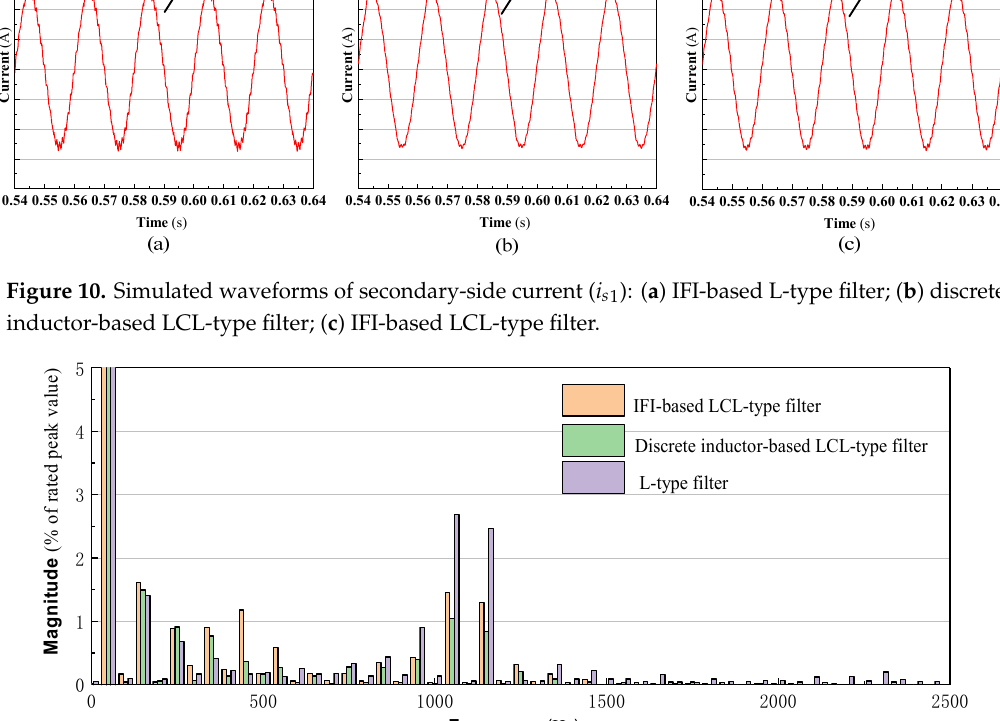
Figure 10. Simulated waveforms of secondary-side current ( i s 1 ): ( a ) IFI-based L-type filter; ( b ) discrete inductor-based LCL-type filter; ( c ) IFI-based LCL-type filter.